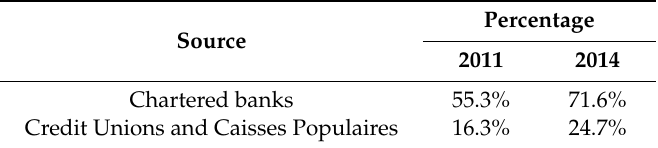
Table A1. Major sources of debt financing in Canada (by the percentage of firms among firms requesting external